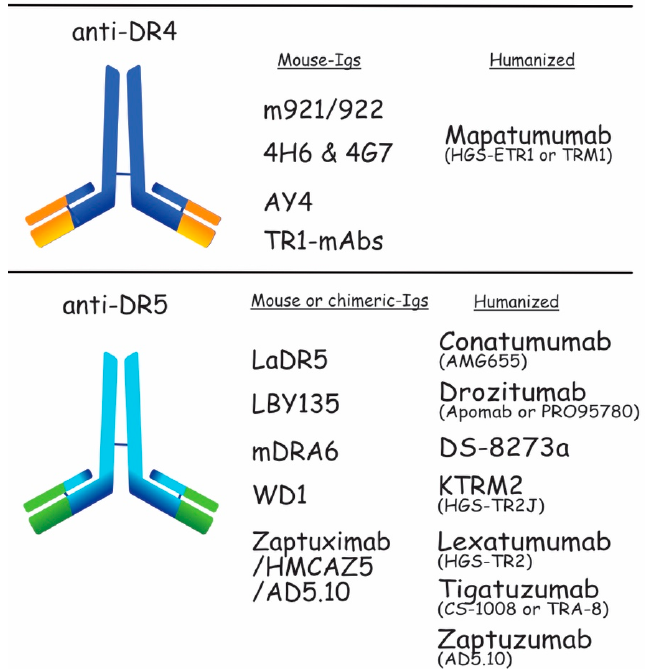
Figure 5. Schematic representation of the DR4 and DR5 moAb. Anti-DR4 developed in preclinical